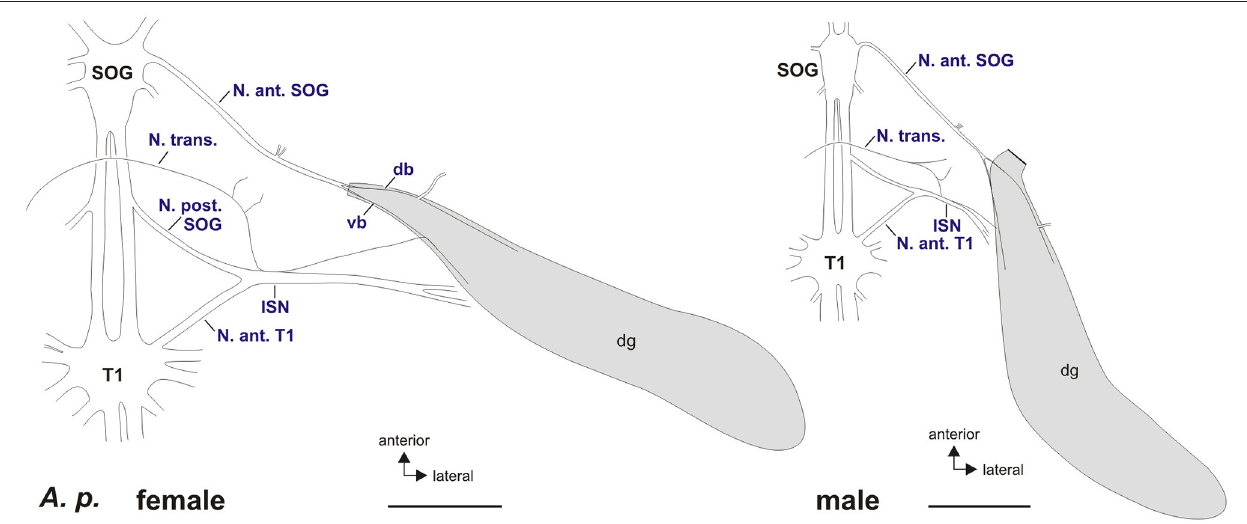
FIGURE 3 | Schematic of peripheral nerves contacting the defense glands in A. paromalus female (left) and male (right) . The defense glands are innervated by the Nervus anterior of the subesophageal ganglion (N. ant. SOG) and the intersegmental nerve complex (ISN) formed by the Nervus transversus (N. trans.), Nervus posterior of the subesophageal ganglion (N. post. SOG), and the Nervus anterior of the prothoracic ganglion (N. ant. T1) via a small nerve branch. The N. anterior SOG splits into a dorsal branch (db) and a ventral branch (vb) which contact the gland muscles. Scales = 2mm. db, dorsal branch of N. anterior SOG; dg, defense glands; ISN, intersegmental nerve complex; N. ant. SOG, Nervus anterior of the subesophageal ganglion; N. ant. T1, Nervus anterior of the prothoracic ganglion; N. post. SOG, Nervus posterior of the subesophageal ganglion; N. trans., Nervus transversus; SOG, subesophageal ganglion; T1, prothoracic ganglion; vb, ventral branch of N. anterior SOG.